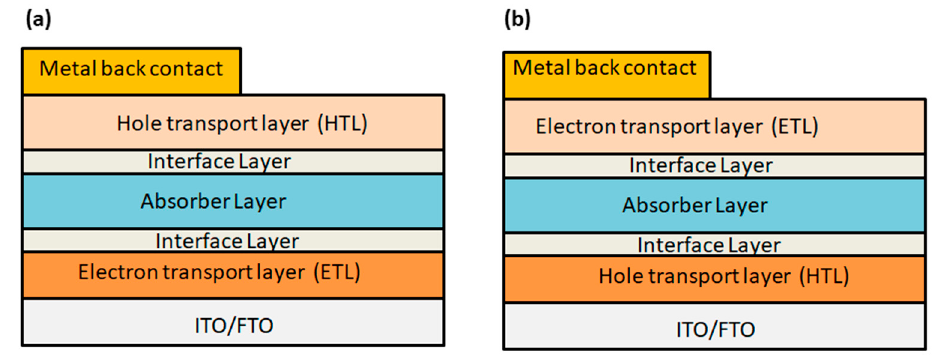
Figure 3. Demonstration of device structure of PSC: ( a ) n-i-p structure, ( b ) p-i-n